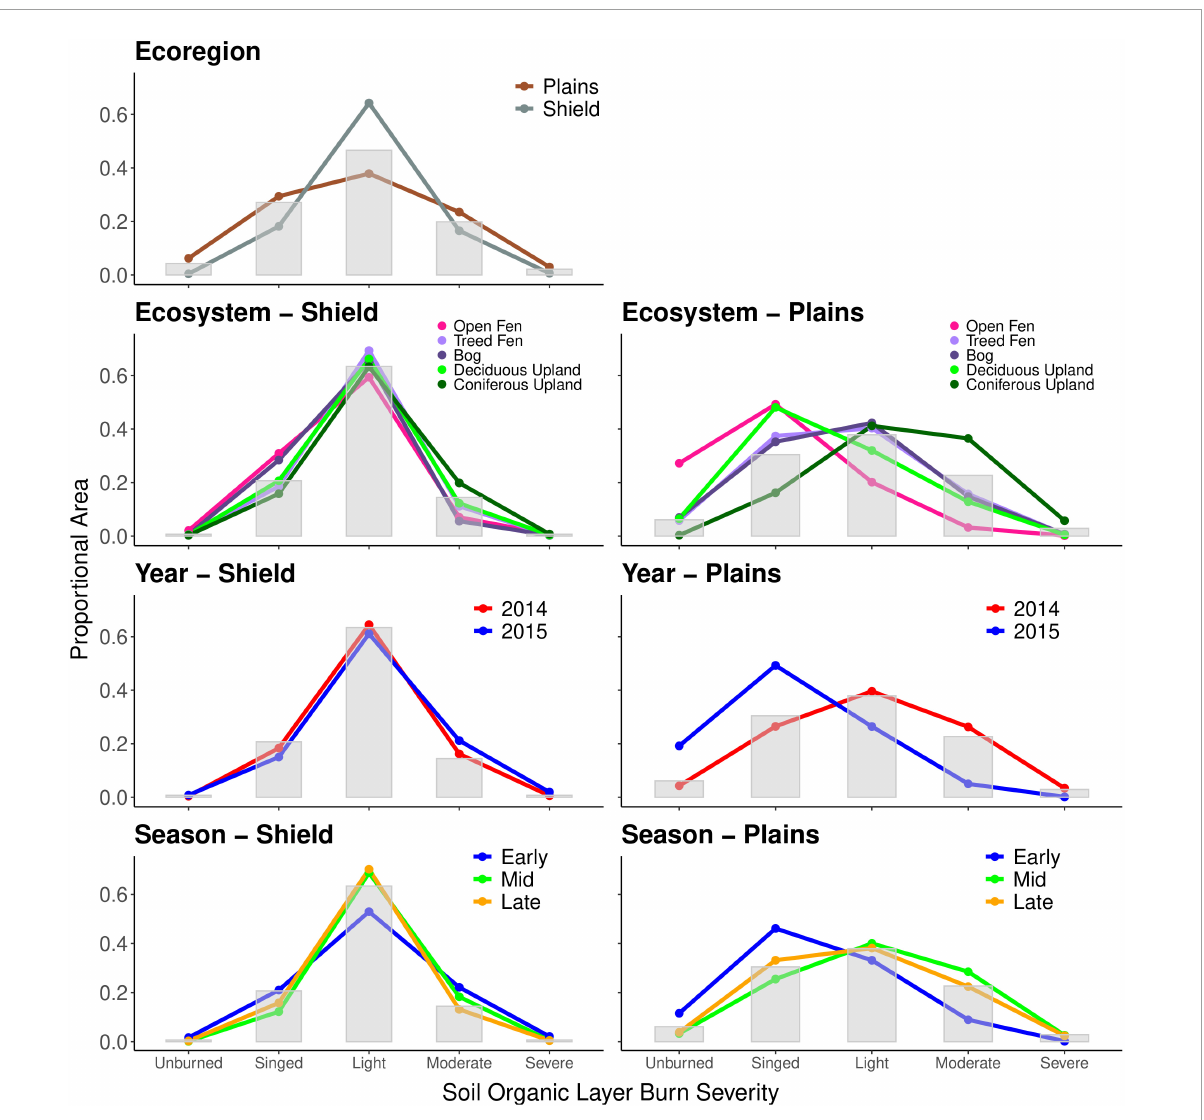
FIGURE10 Expected (gray bars) and actual proportional area (colored lines and points) showing sensitivity to wildfire (burn severity) by ecoregion on the Taiga plains, by ecosystem type on the Taiga shield, by Ecosystem type on the Taiga plains, by year on the Taiga shield, by year on the Taiga plains, by season on the Taiga shield, and by season on the Taiga